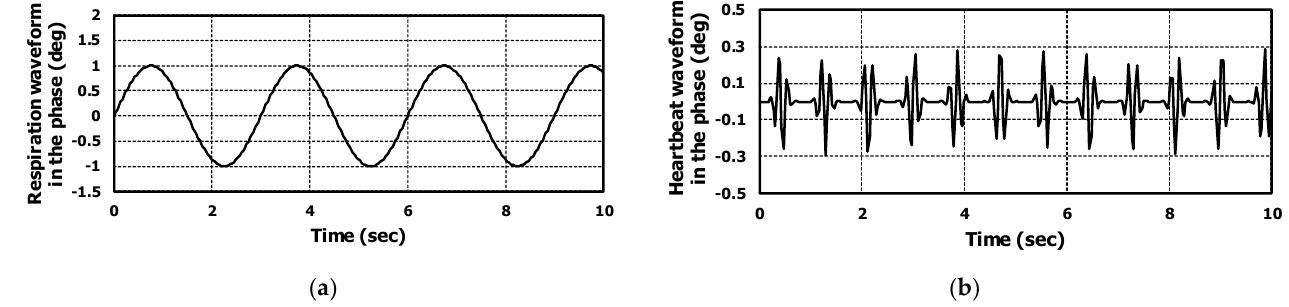
Figure 4. The simulation results of ( a ) respiration and ( b ) heartbeat signal model. The target information of respiration and heartbeat rates was 70 and 20, respectively.